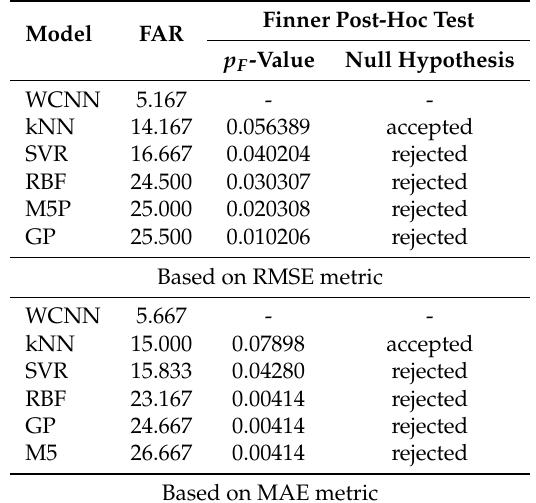
Table 4. FAR test and Finner post-hoc test comparing all regression